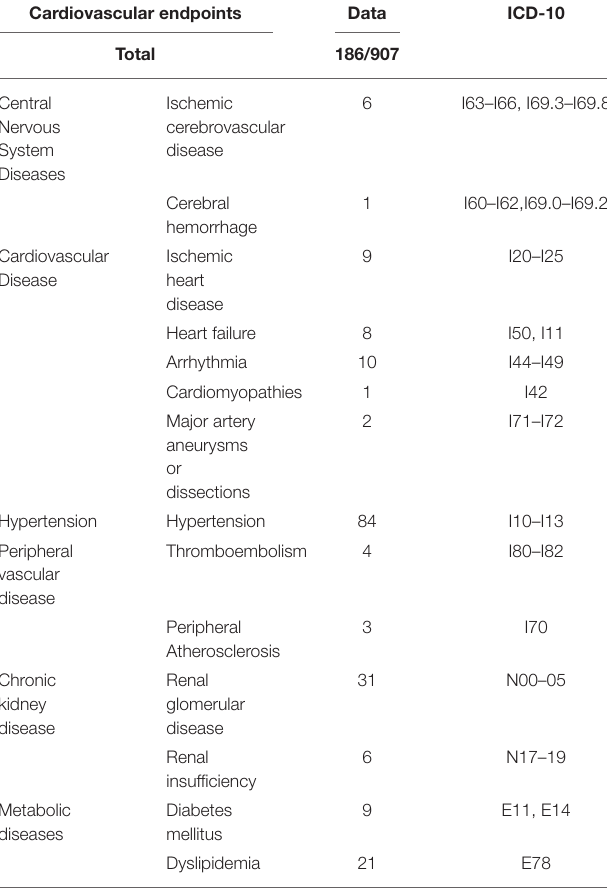
TABLE 2 | Occurrence of cardiovascular endpoints in women following preeclampsia by morbidity